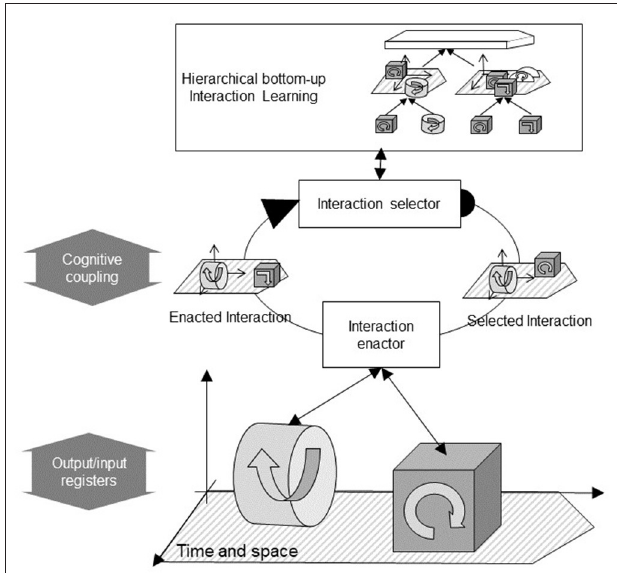
FIGURE 1 | The interaction control mechanism. Cylinders and cubes with arrows represent predefined primitive interactions enacted through control loops. The interaction learning mechanism (top) learns composite interactions (flat arrows) made of hierarchies of interactions organized in time and space. The interaction selector (center) selects a previously learned interaction for enaction (right). The interaction enactor controls the sequential enaction of the selected interaction in time and space (bottom) and returns the enacted interaction (left), which may differ from that selected depending on the environment. The coupling between the interaction selector and the interaction enactor constitutes the cognitive coupling. It is distinct from the software/world coupling defined by the input and output